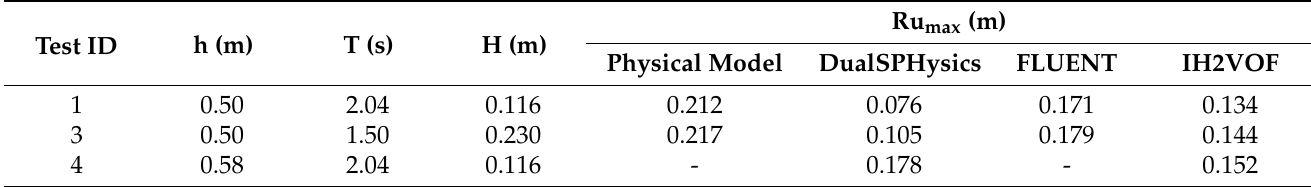
Table 12. Maximum run-up calculated by physical and numerical models.